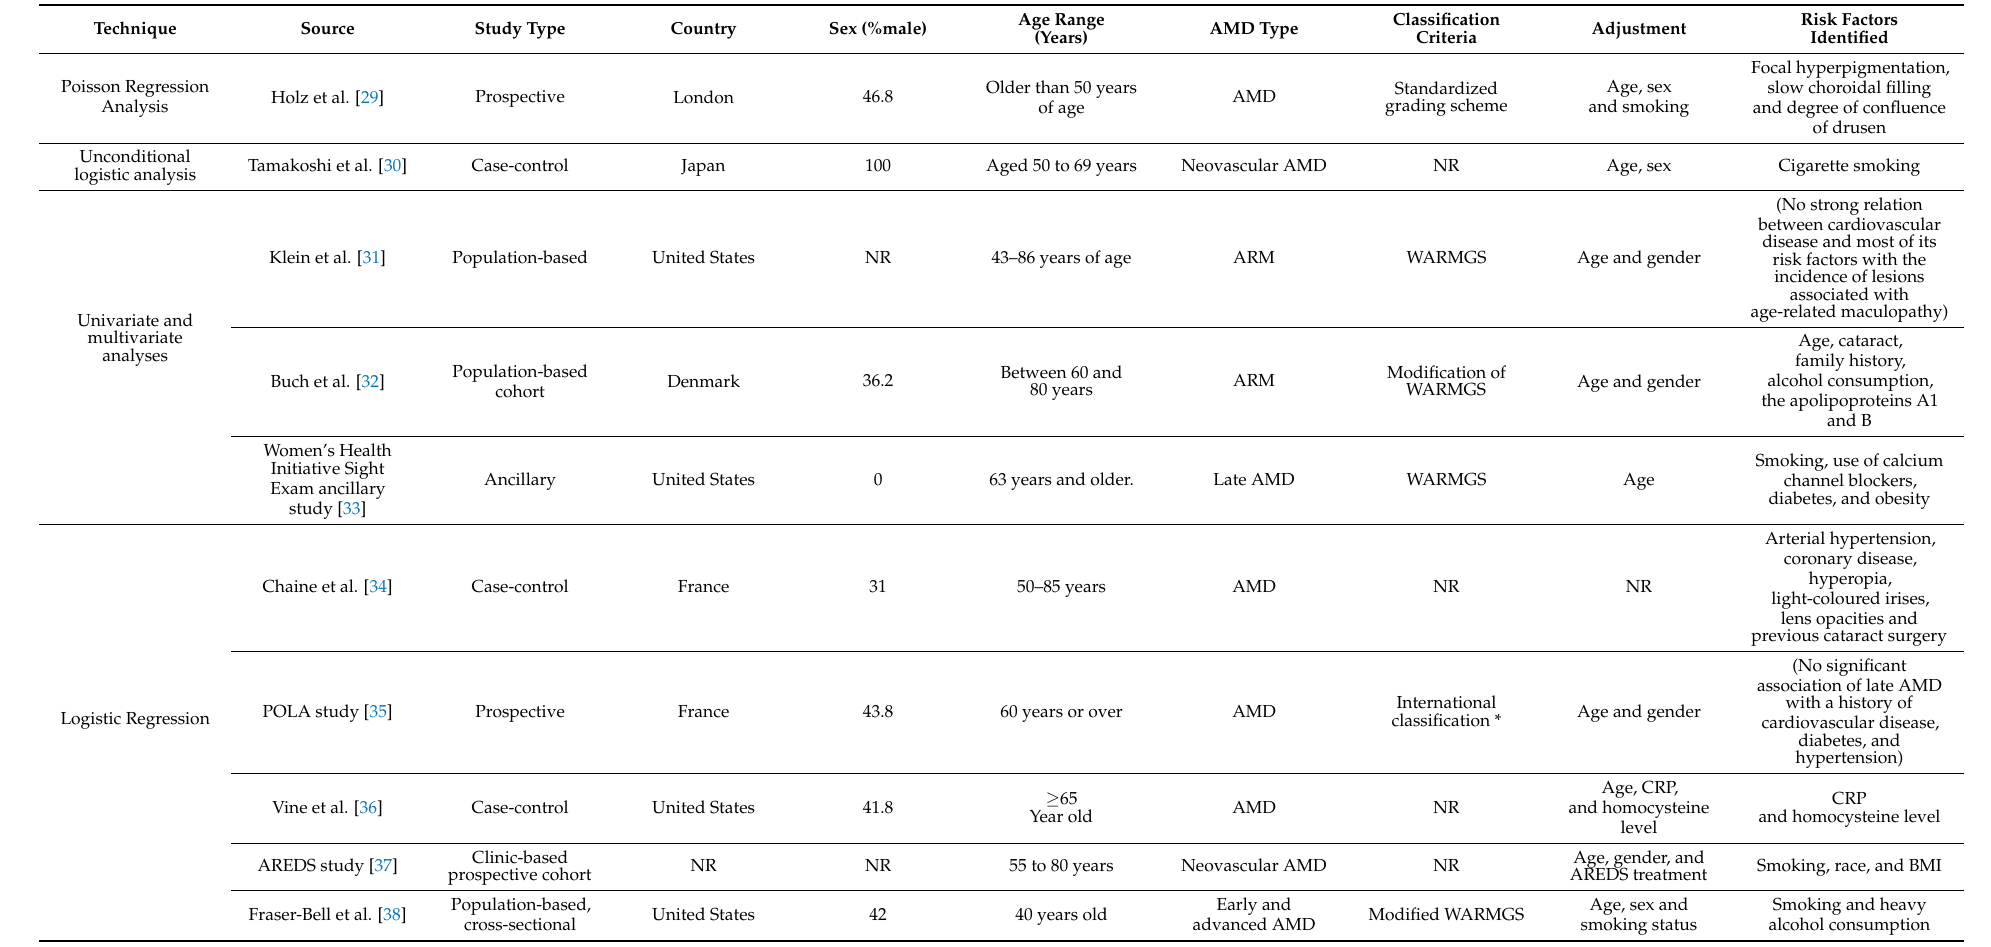
Table 1. The summarized review of statistical techniques for